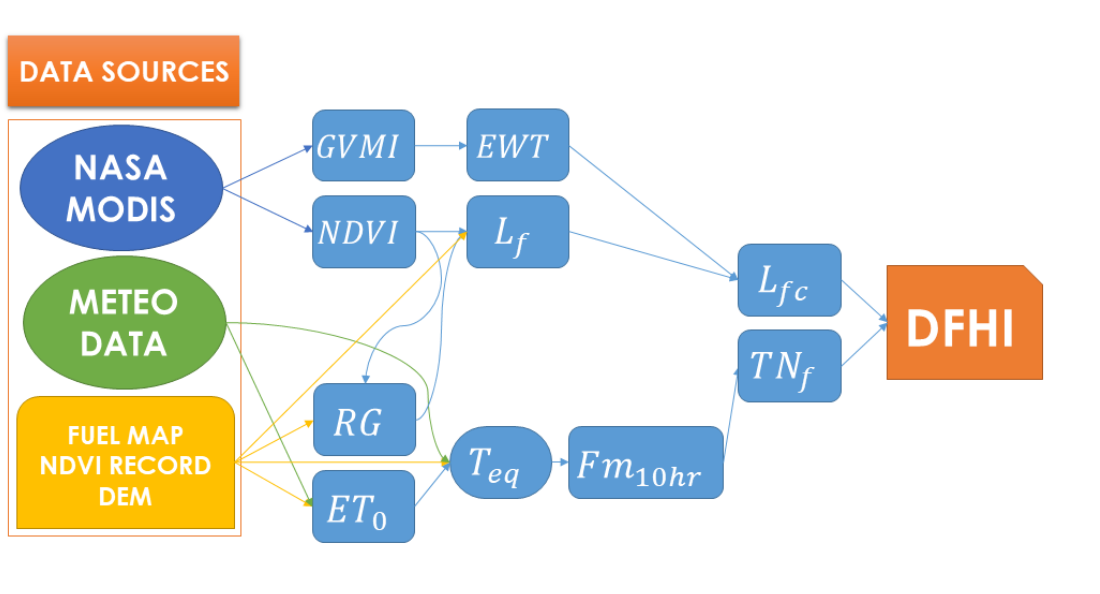
Figure 2. Simplified flowchart of the DFHI (Daily Fire Hazard Index) algorithm.